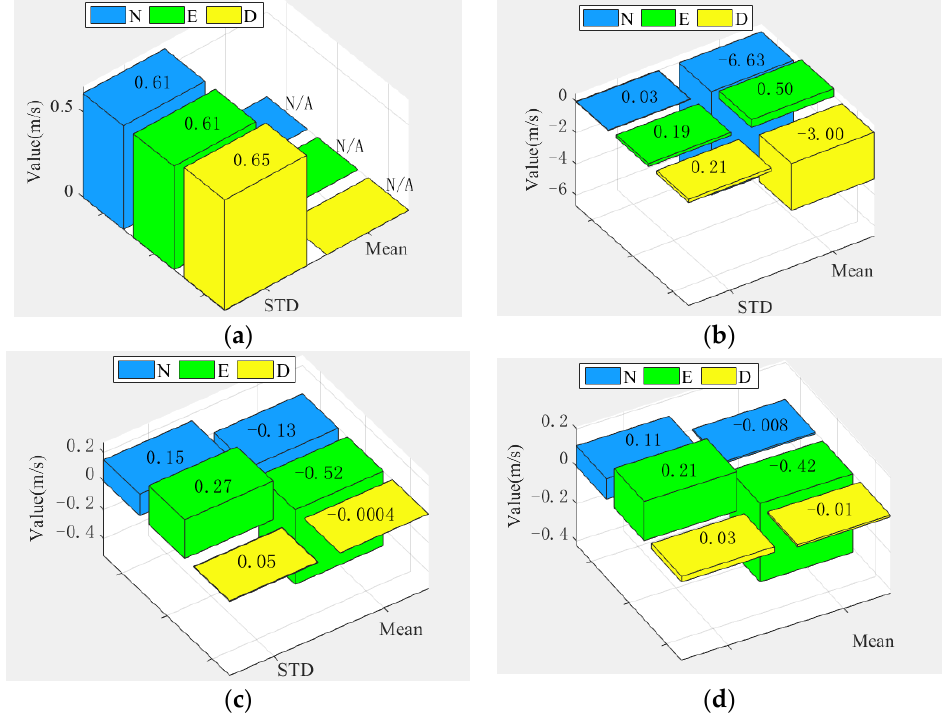
Figure 10. Histogram of position error statistics comparison. ( a ) Huang [39], ( b ) Hsu [40], ( c ) Ye [24], and ( d ) this paper.